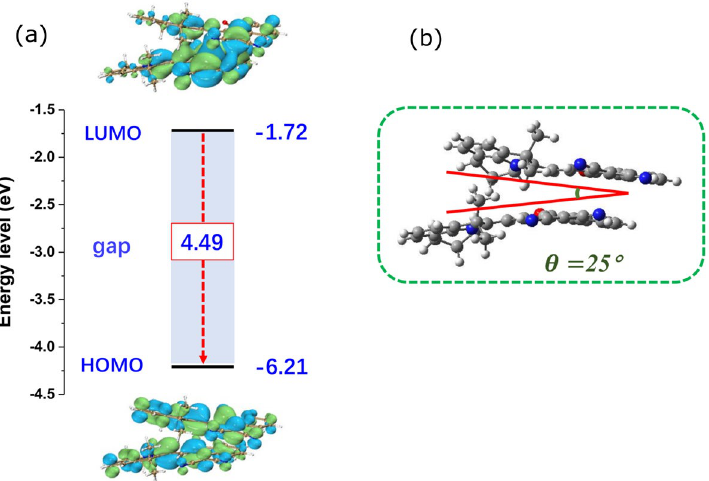
Figure 6. Dimer model to explain anomalous emission in EG solvent. ( a ) the excited-state energy levels with HOMO/LUMO orbitals. ( b ) molecular orientation of HB194 dimer showing the angle of 25° between the molecular